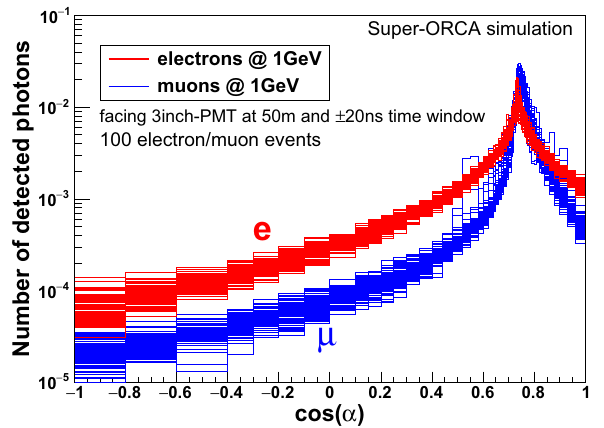
Fig. 13 Sensitivity to exclude certain values of δ CP with Super-ORCA after 3 years of data taking as a function of the tested δ fit for 4 example CP values of the true δ CP . A 450kW beam from Protvino with 1.5 years in neutrino mode and 1.5 years in antineutrino mode is assumed (solid lines). The corresponding sensitivity for Super-ORCA using 3 years of atmospheric neutrino data is shown by dashed lines for